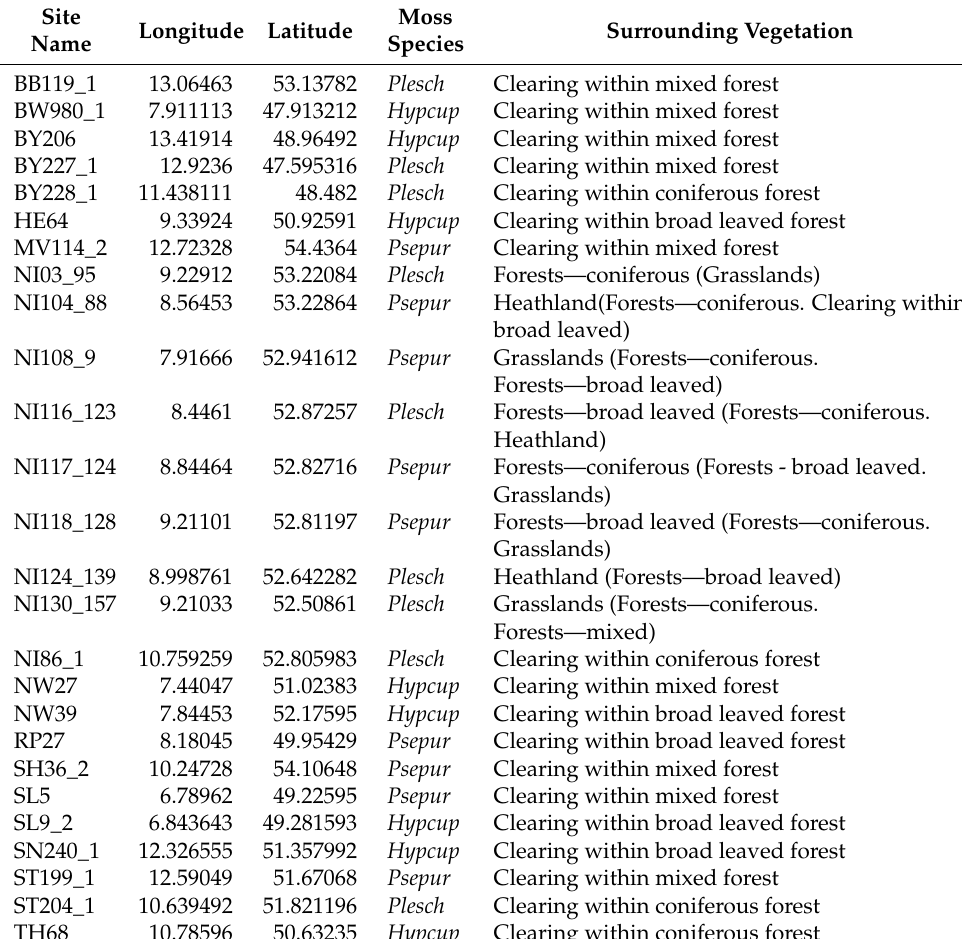
Table 1. Sampling sites in Germany 2020 for monitoring metal and nitrogen concentrations in moss.